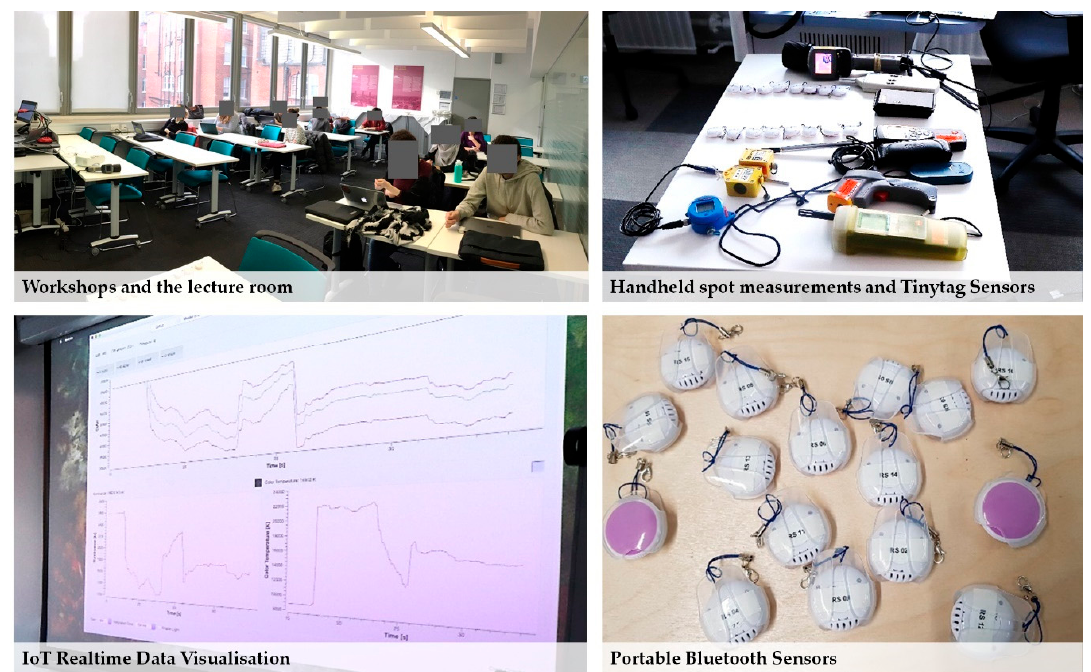
Figure 6. Use of IoT data visualisation, portable Bluetooth sensors and other equipment for educational workshops (source: photo archive of ‘Realising Sustainability Project’).